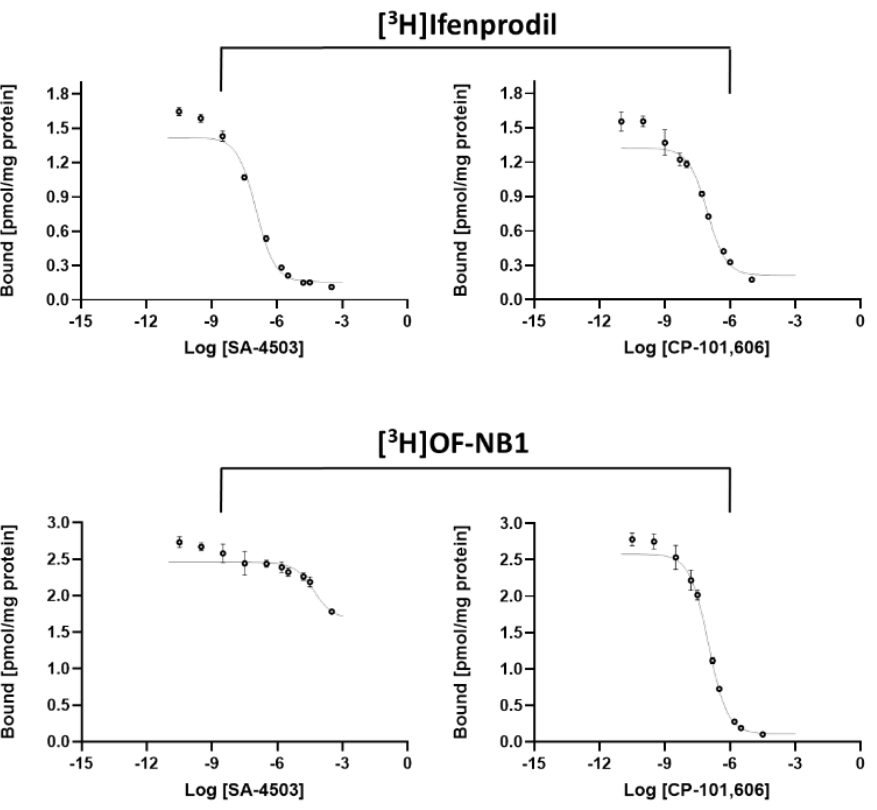
Figure 2. Representative saturation binding curves of the σ 1R ligand SA-4503 (left) and the GluN1/2B antagonist CP-101,606 (right) using the two radioligands [ 3 H]ifenprodil and [ 3 H]OF-NB1.